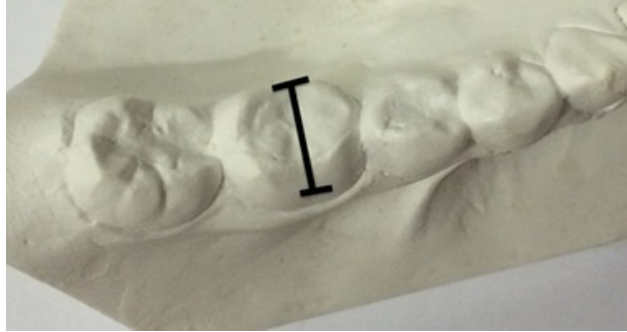
Fig.2. Buccolingual/Palatal distance. Source: current research.